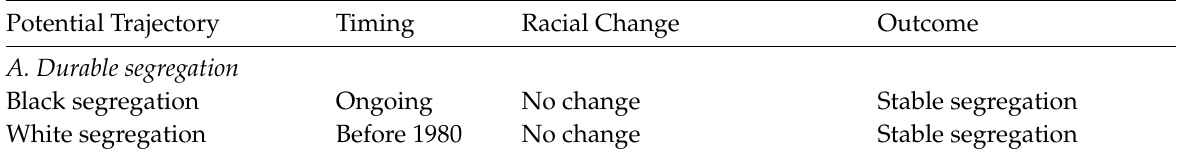
Table 1: Potential neighborhood racial change trajectories in post-Civil Rights